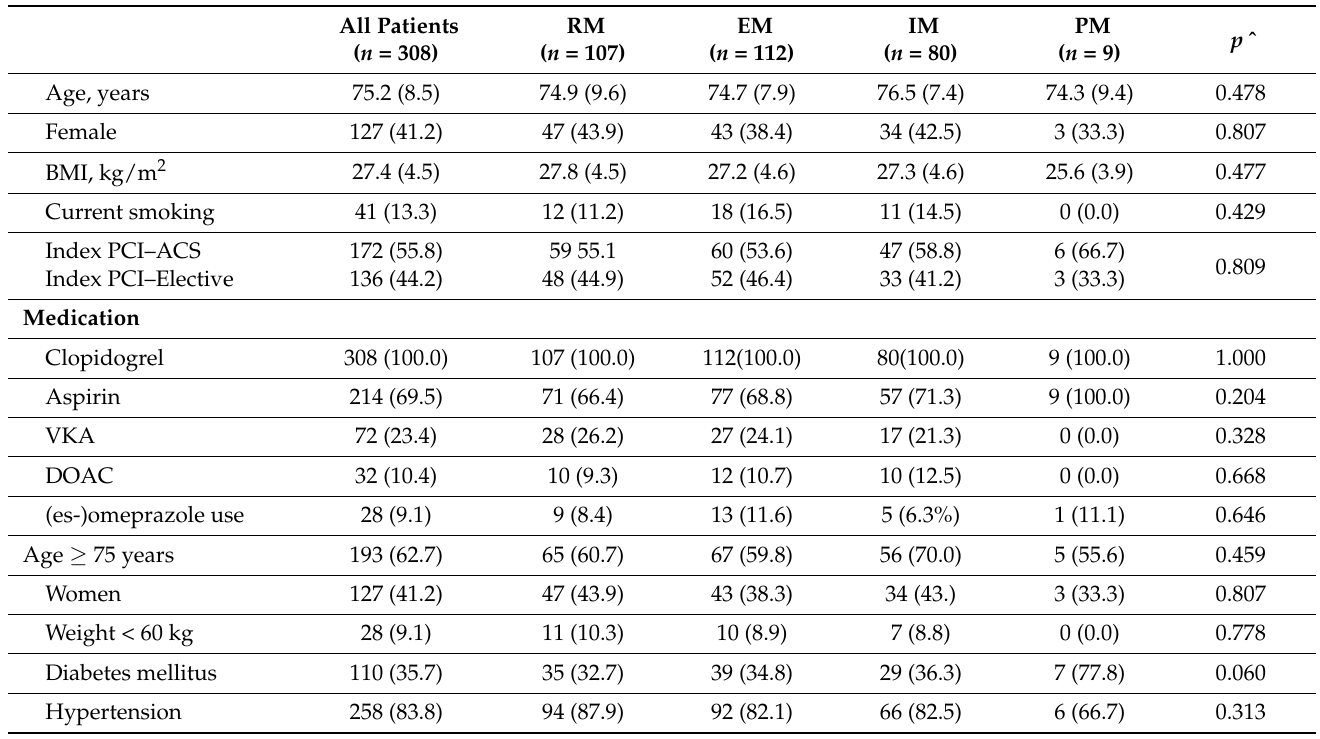
Table 1. Baseline characteristics for the different metabolizer